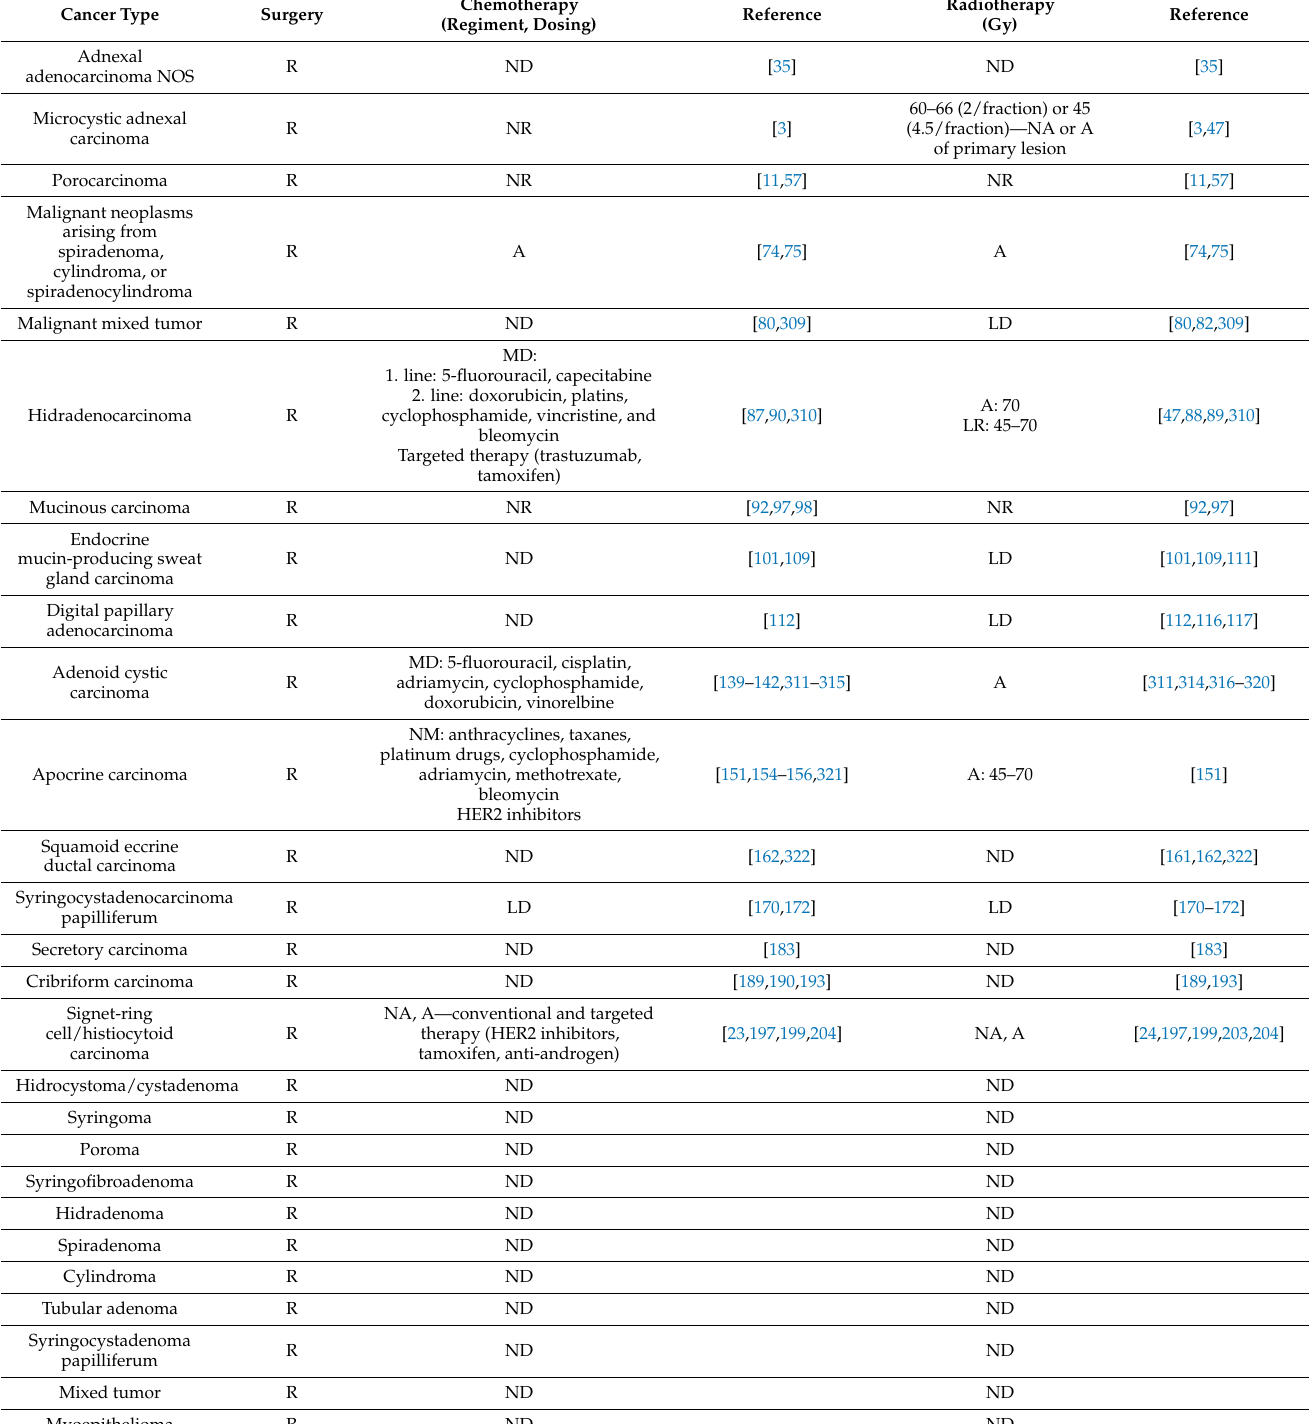
Table 2. The multidisciplinary treatment cases reported for appendageal